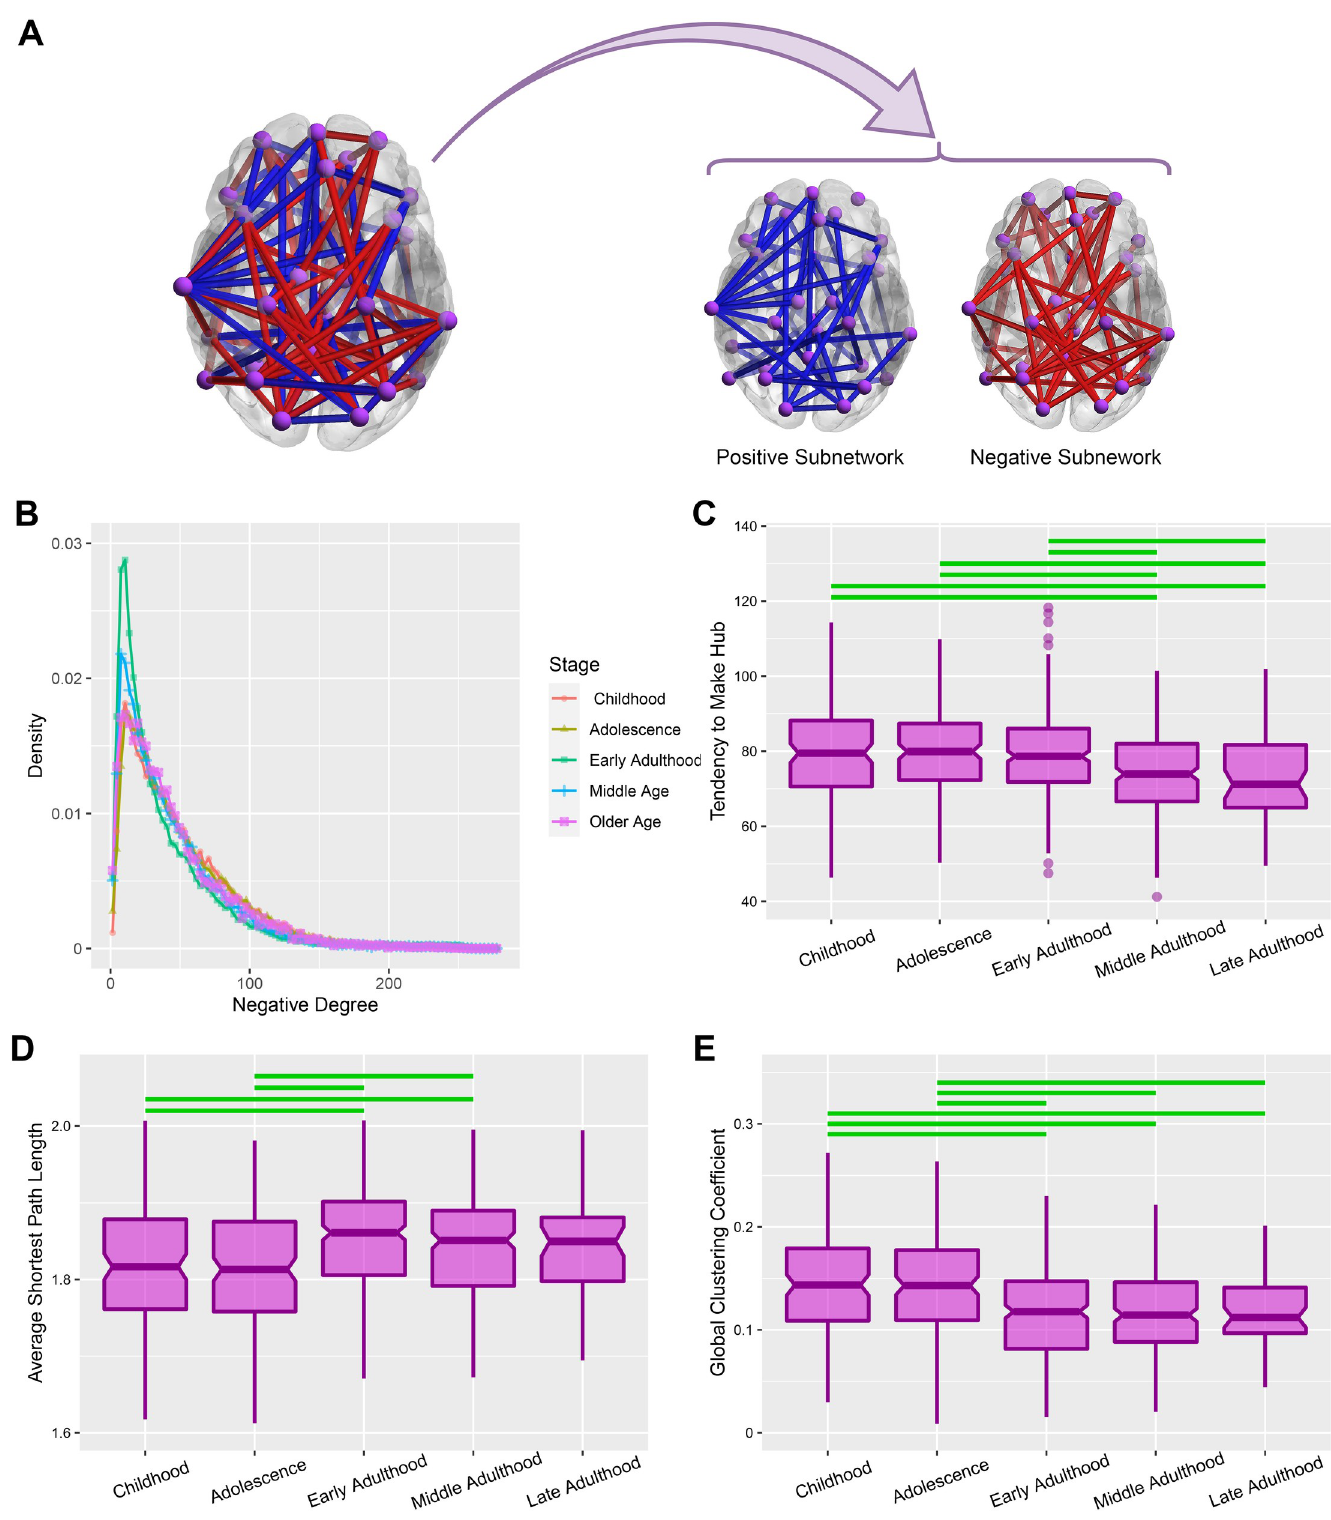
Fig 4. Topological analysis of brain negative subnetwork. (A) Splitting brain signed network to positive and negative subnetworks. (B) Stagewise degree distributions of brain negative subnetwork. (C-E) Alteration of three global features of hubness, efficiency and clustering of brain negative subnetwork over the lifespan stages. These features are measured using Tendency to Make Hub, Average Shortest Path Length, and Global Clustering Coefficient. The notched regions of boxes indicate median and 95% confidence interval of the median, and horizontal lines denote between stages significant differences after multiple comparison correction (corrected p-value �